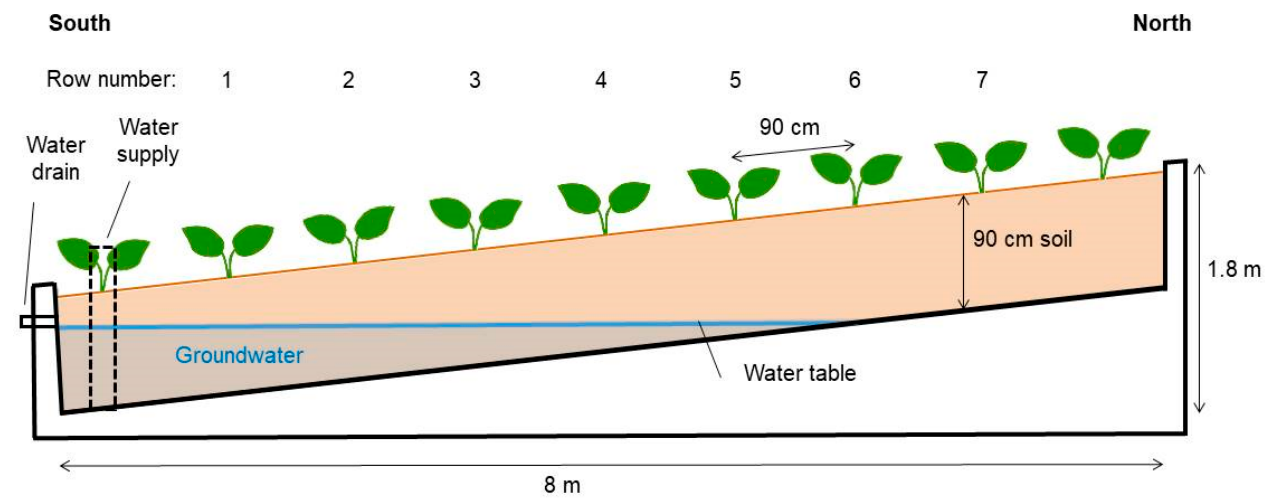
Figure 1. Scheme of a groundwater tank in longitudinal section.